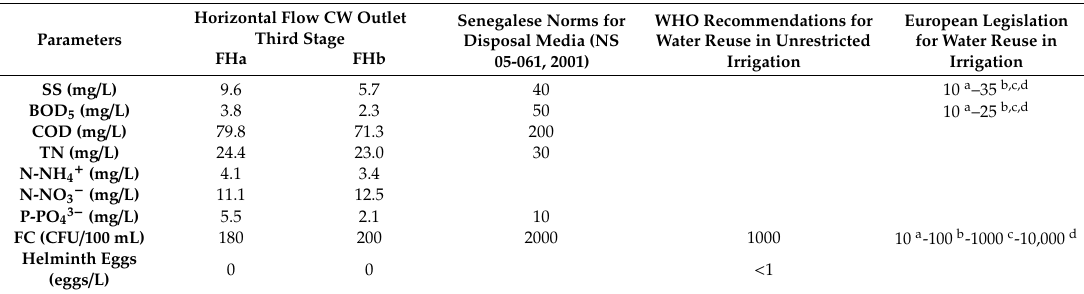
Table 7. CW e ffl uent quality comparison with the Senegalese, EU, and WHO quality requirements or recommendations for disposal and water reuse in